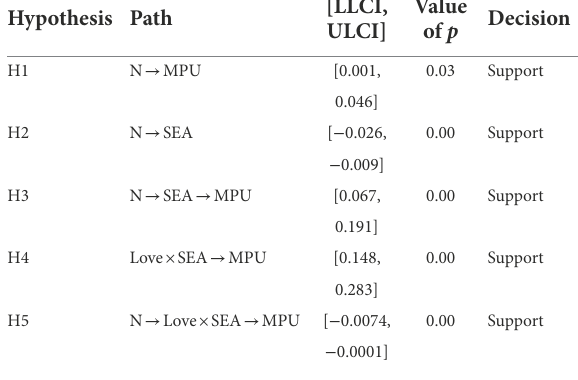
FIGURE 2 Moderating effect of love status.